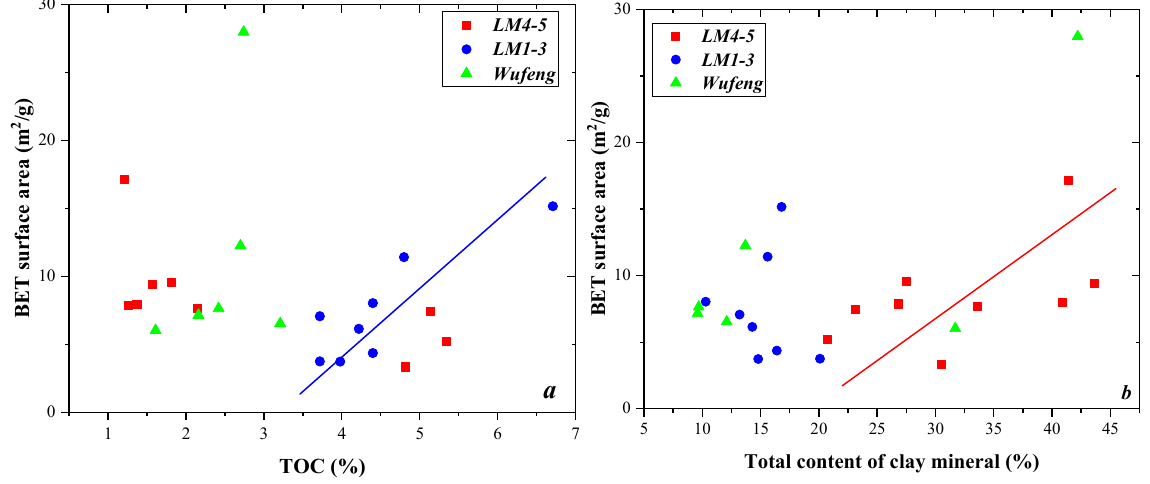
Figure 14. The correlation between BET surface area and the TOC content ( a ), clay mineral content ( b ) in well L204 (sample L204-4 has extremely large BET value, and was not included in the two figures). Information of sample L204-5: TOC-5.25%; quartz content: 65.8%; clay content: 11.6%; BET: 56.87 m 2 /g; BJH volume: 0.0534 cm 3 /g.